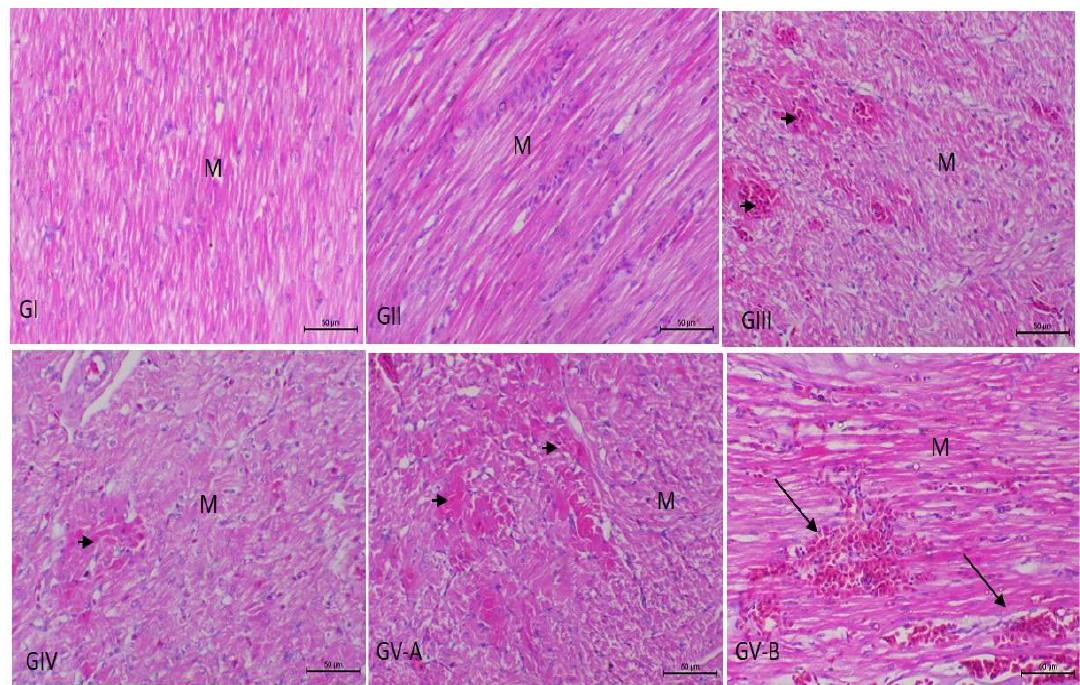
Figure 2. Photomicrograph of heart sections from experimental groups stained with Hx & E stain. GI and GI1: the heart shows a normal arrangement of cardiac muscle fibers (M); GIII and GIV: focal muscle necrosis (arrowhead); GV-A: massive myocardial necrosis (arrowhead); GV-B: myocardial hemorrhage with extravasated RBCs in-between the cardiac muscle fibers (arrows). The bar size of each picture is included under each picture.